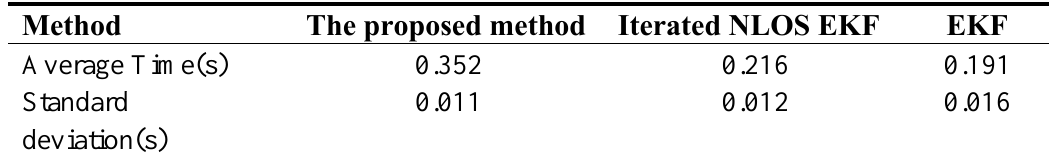
Table 2. Computer running time of the three